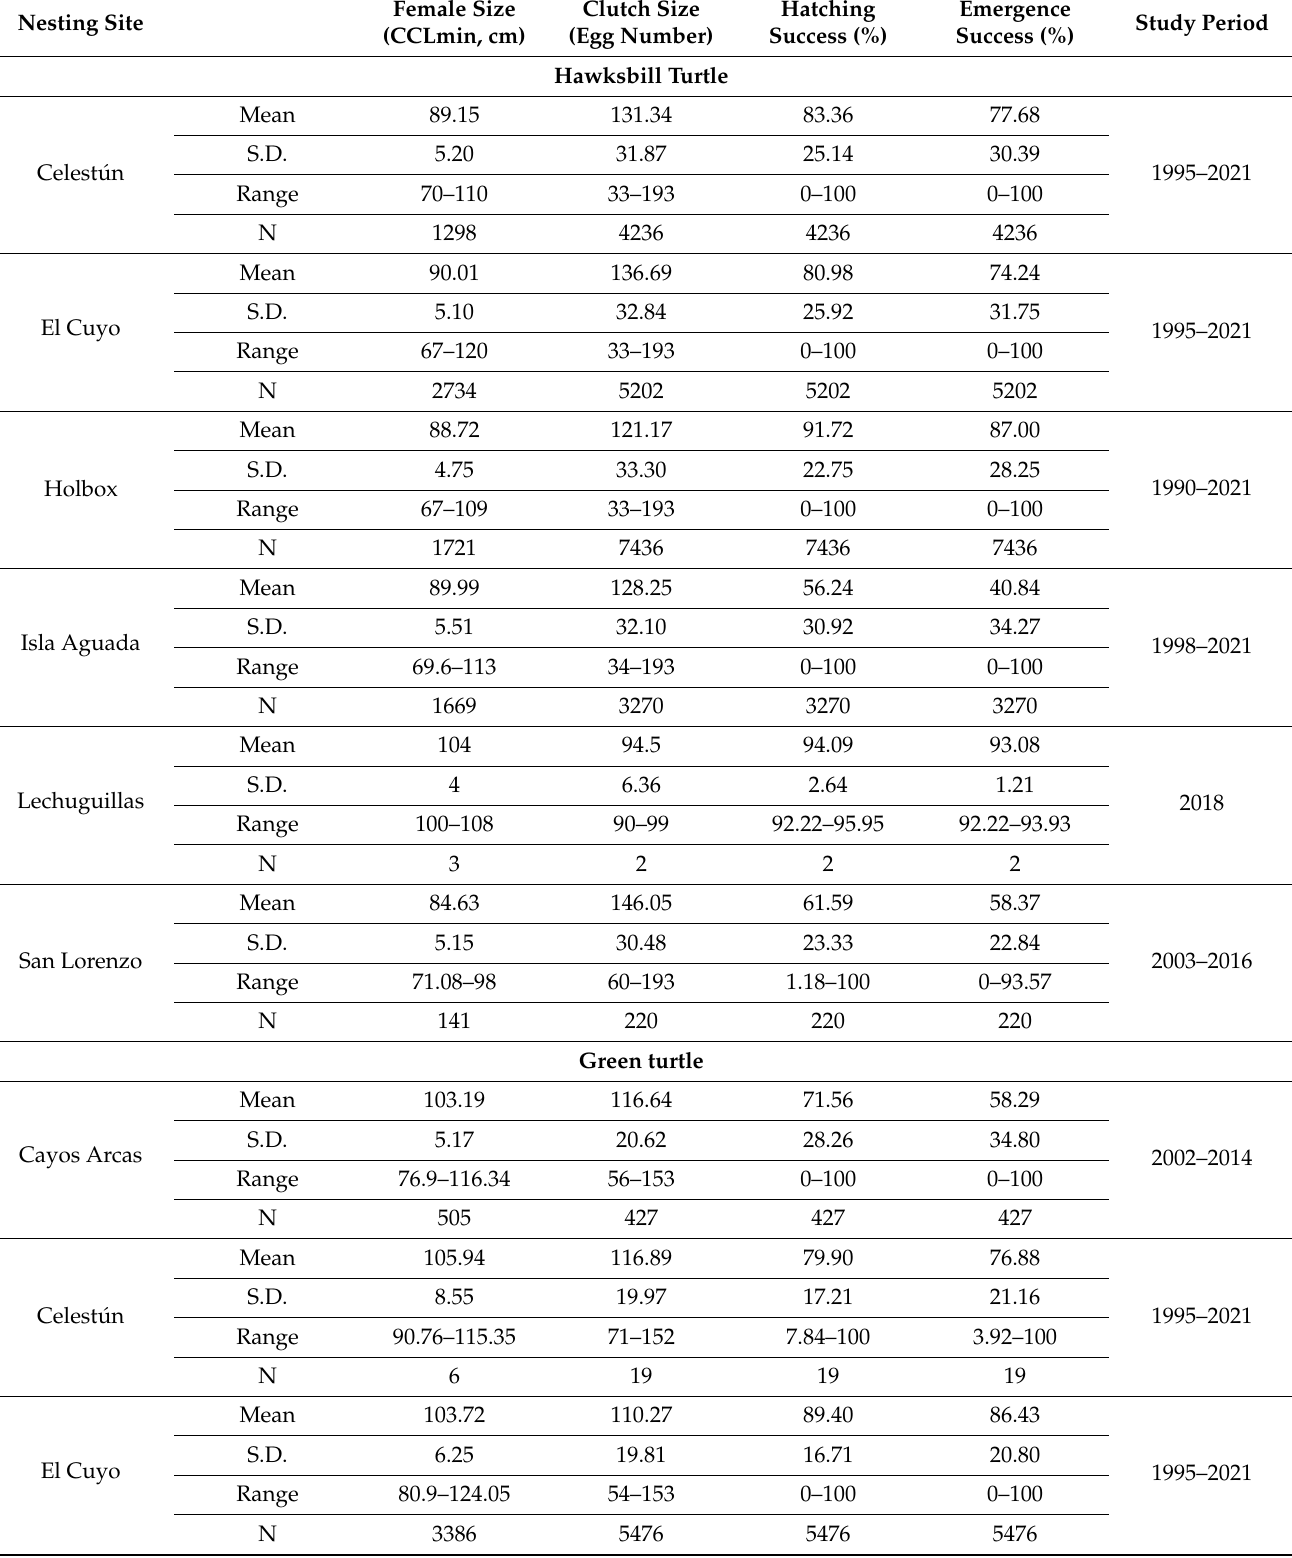
Table 4. Summary statistics for morphological and reproductive indicators of hawksbill ( Eretmochelys imbricata ) and green ( Chelonia mydas ) turtles that nested at seven index beaches in the Gulf of Mexico from 1990 to